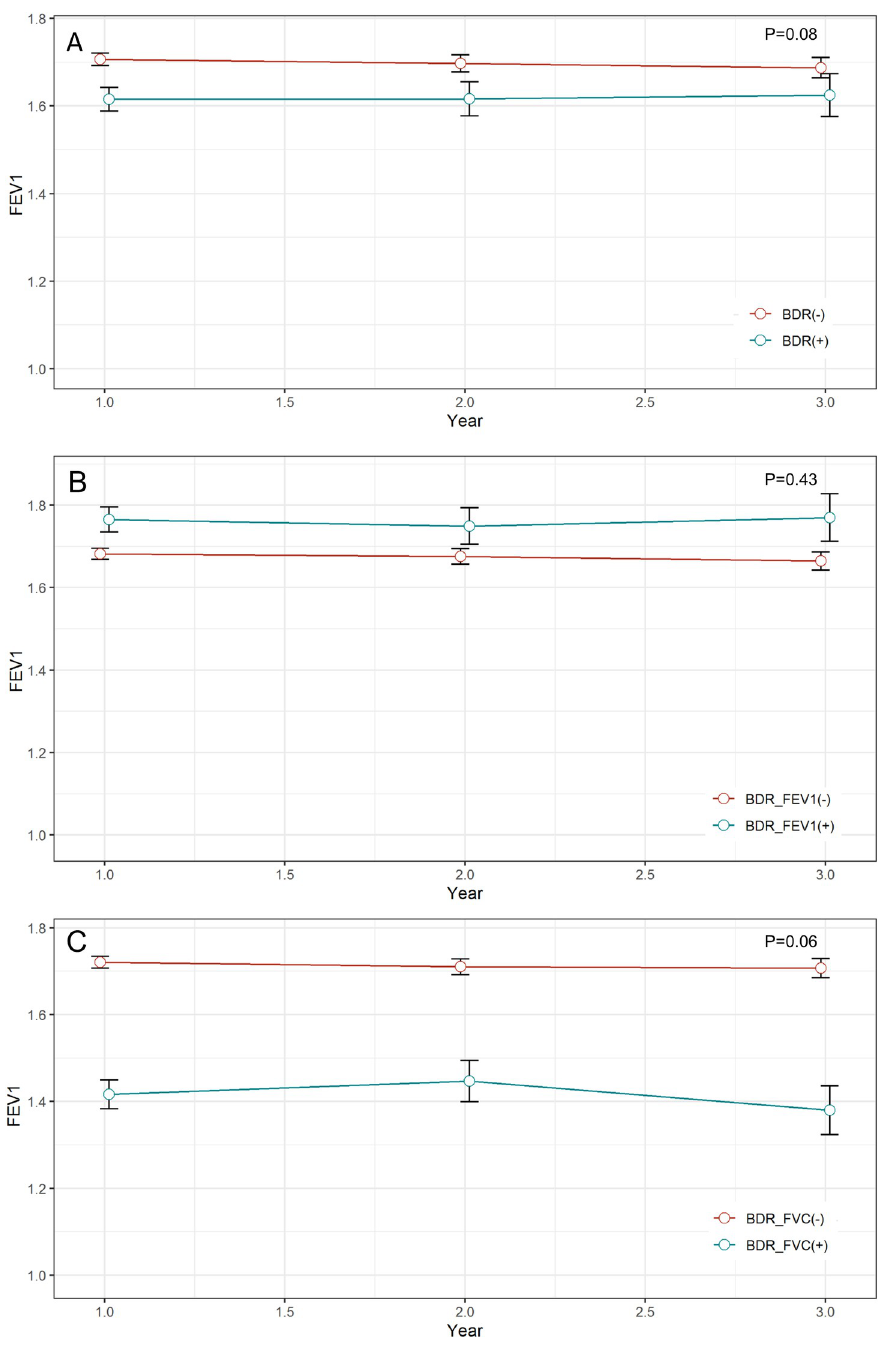
Fig 2. Difference of lung function trajectories according to (A) BDR, (B) BDR-FEV1, and (C) BDR-FVC. mMRC and CAT scores, which may be because BDR and BDR-FVC were more frequently present at higher GOLD stages compared to BDR-FEV1. Also, BDR-FVC are reported to be associated with lung hyperinflation and gas trapping causing more dyspnea symptom and lower exercise capacity [11, 33].